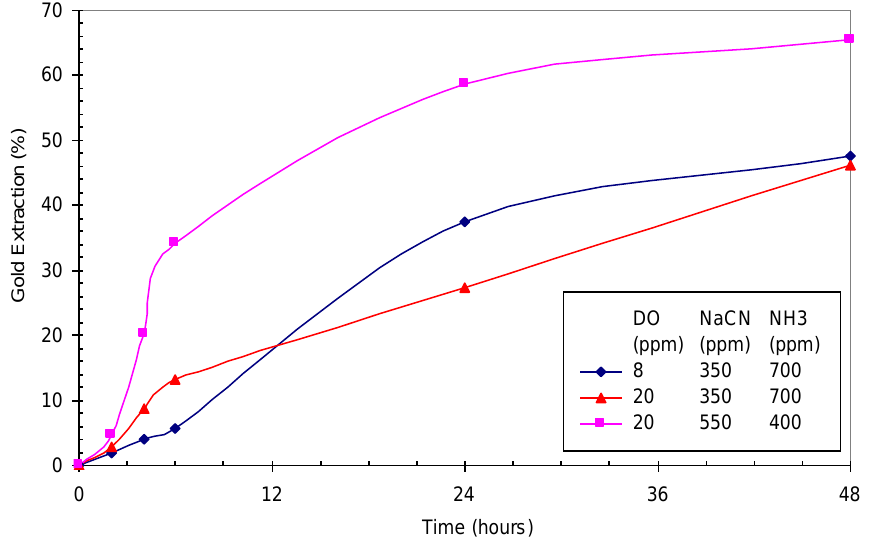
Figure 7. Hunt leaching test under typical Hunt conditions; 0.3% Cu as bornite, pH